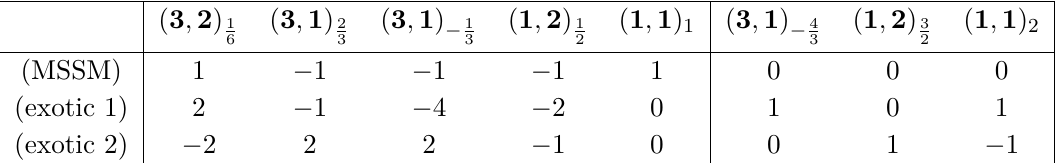
Table 3 . Multiplicities of the three anomaly-free families of generic chiral matter in 4D models with (SU(3) × SU(2) × U(1)) / Z gauge 6